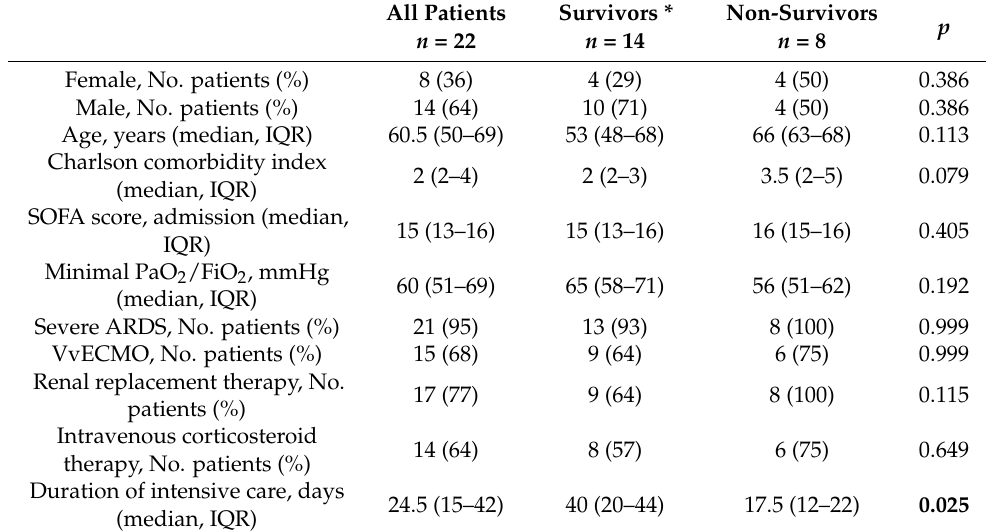
Table 1. Demographics and course of intensive care.